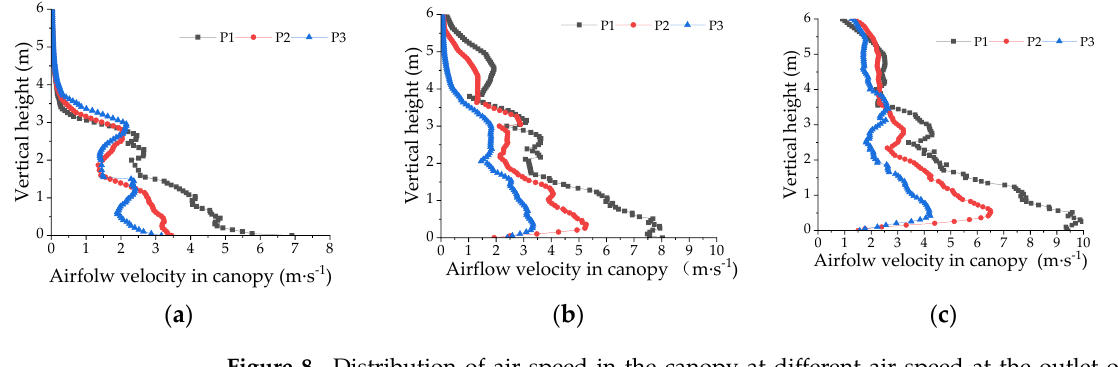
Figure 8. Distribution of air speed in the canopy at different air speed at the outlet of the fan. ( a ) v = 15 m/s; ( b ) v = 20 m/s; ( c ) v = 25 m/s.